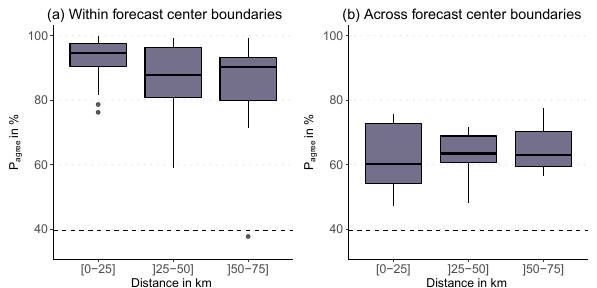
Figure 6. Box plot showing the agreement rate ( P agree ) for neigh- boring warning region pairs (a) within and (b) across forecast center boundaries, stratified by the distance between the cen- ter points of warning regions, with similar maximum elevation ( (cid:49) elevation < 250m) and size (the size of the larger warning re- gion is less than 1.5 times the size of the smaller warning re- gion; N (within) = 108, N (across) = 37). The dashed line represents P agree when randomly drawing 10000 danger levels for neighbor- ing warning regions using the distributions shown in Fig. 4a (dis- cussed in Sect. 6.2). The box plots show the median (bold line), the interquartile range (boxes), 1.5 times the interquartile range (whiskers), and outliers outside this range